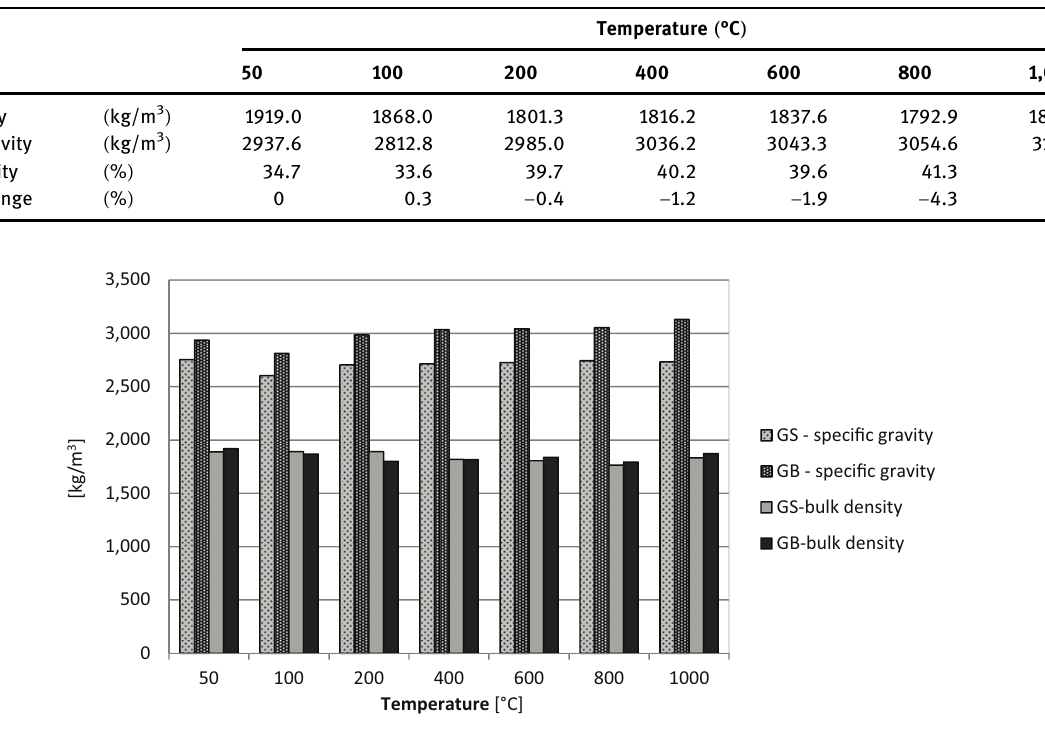
Table 6: Basic physical characteristic of composite with basalt ( GB )